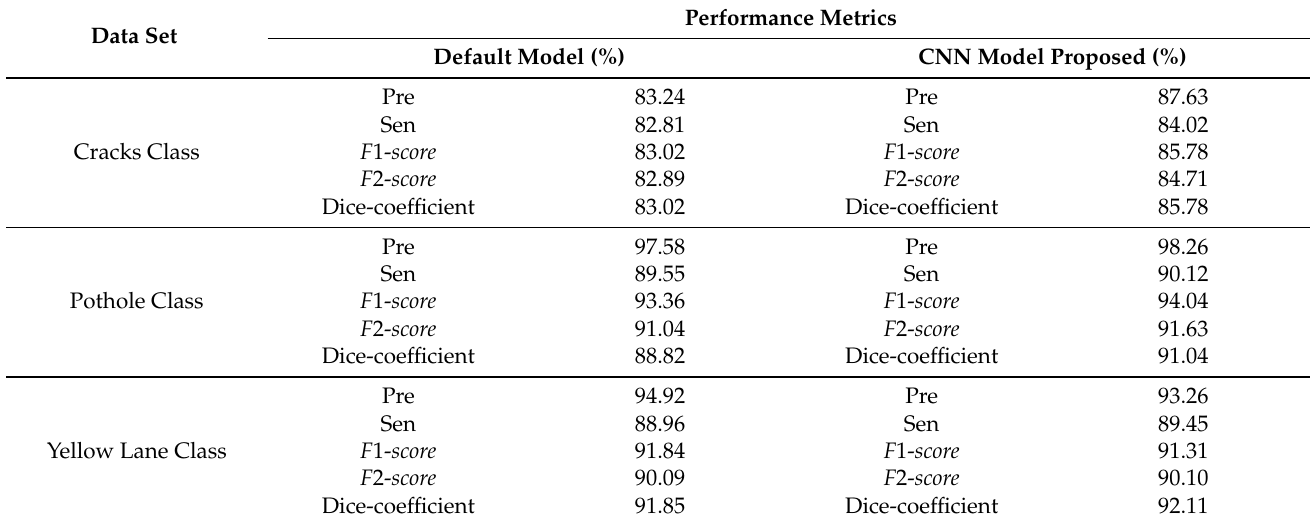
Table 2. The performance comparison with respect to detection of the default and proposed